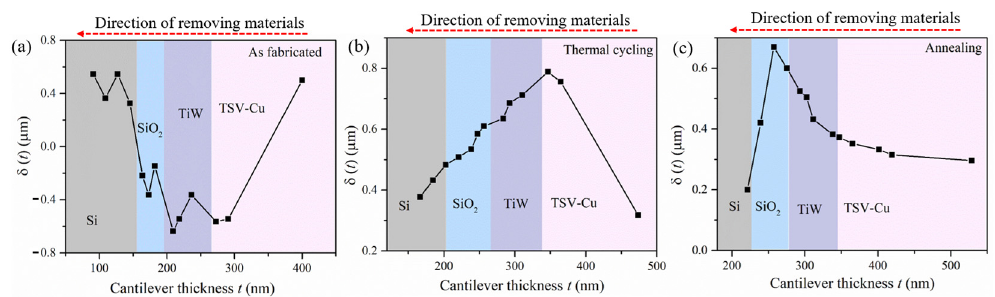
Figure 3. The deflection of samples, ( a ) as-fabricated; ( b ) thermal cycling; ( c ) annealing.